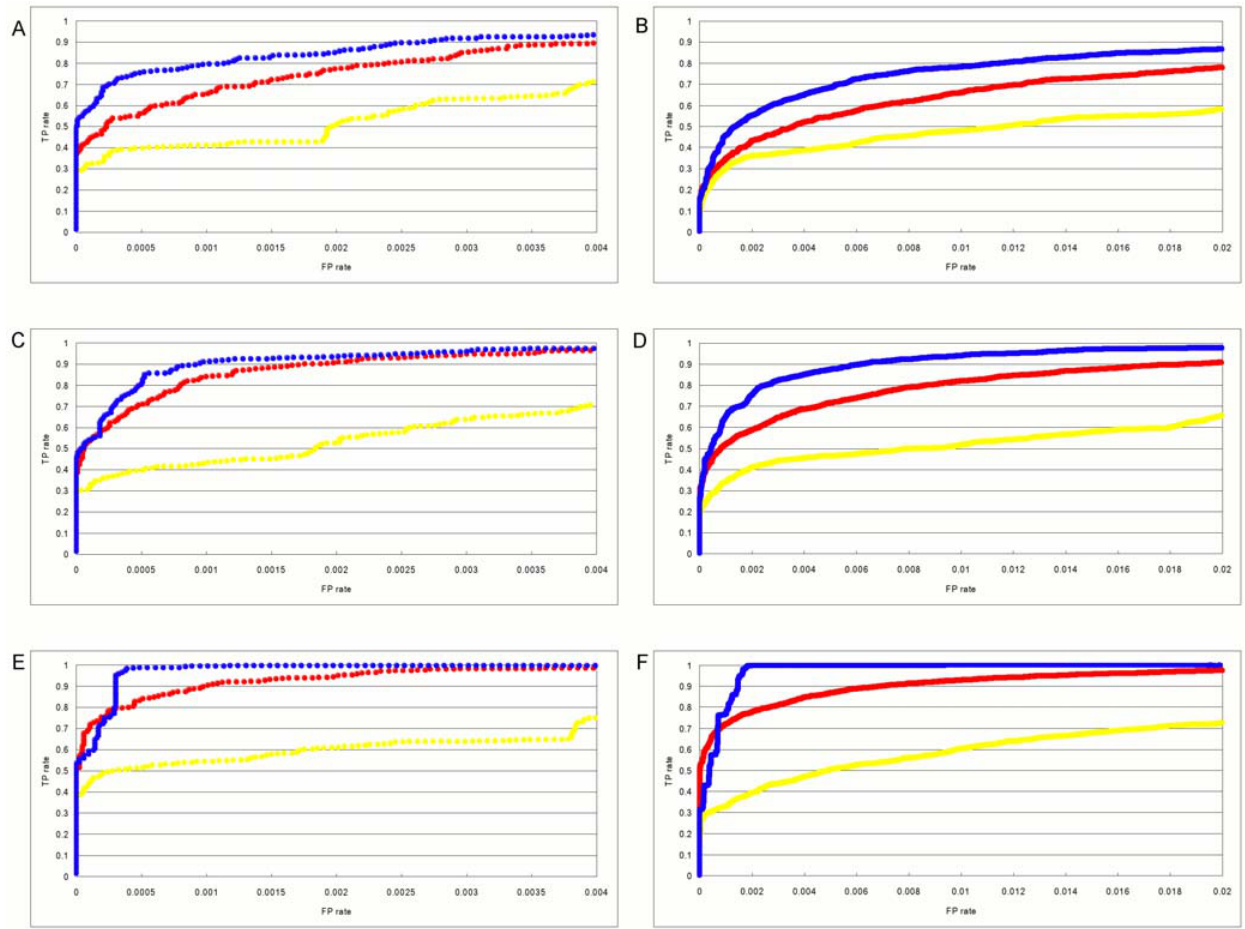
Figure 5. Receiver operator characteristic curves of the position weight matrix models with step-function sampling. The log-odds, Match, and quadratic programming results are denoted by red, yellow, and blue markers respectively. Each data point is the mean of five replicates and points are allowed to overlap. Error as standard deviation of the mean extends from each curve by the size of a single marker. A. Alignments containing 20 sites; cutoff=4. The log-odds, Match, and quadratic programming curves attain TP=1 at FP=0.013, 0.099, and 0.019, respectively. B. Alignments containing 20 sites; cutoff=7. The log-odds, Match, and quadratic programming curves attain TP=1 at FP=0.329, 0.495, and 0.200, respectively. C. Alignments containing 50 sites; cutoff=4. The log-odds, Match, and quadratic programming curves attain TP=1 at FP=0.014, 0.057, and 0.011, respectively. D. Alignments containing 50 sites; cutoff=7. The log-odds, Match, and quadratic programming curves attain TP=1 at FP=0.151, 0.437, and 0.070, respectively. E. Alignments containing 200 sites; cutoff=4. The log-odds, Match, and quadratic programming curves attain TP=1 at FP=0.009, 0.038, and 0.006, respectively. F. Alignments containing 200 sites; cutoff=7. The log-odds, Match, and quadratic programming curves attain TP=1 at FP=0.061, 0.253, and 0.013,